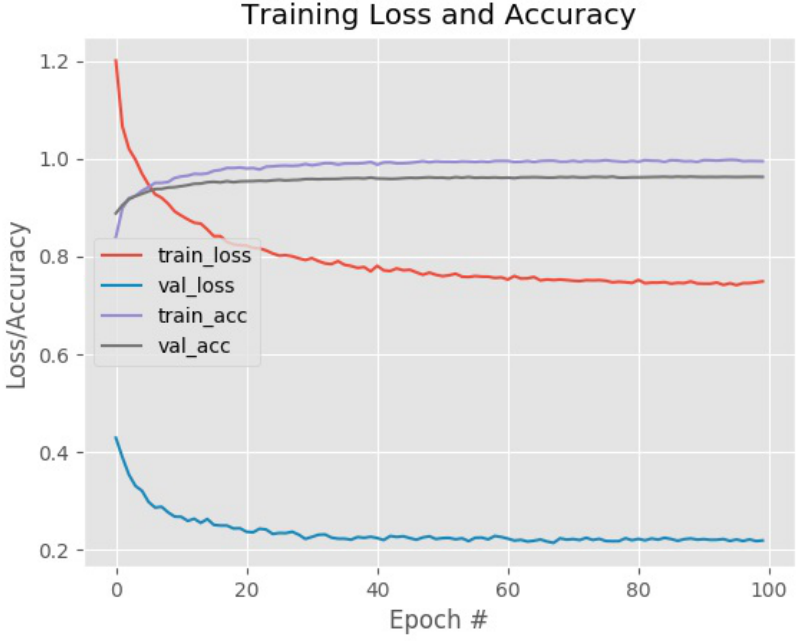
Figure 12. Training plot of the proposed method with 20% of AID data set as the training set for Xception, linear learning rate decay, and softmax